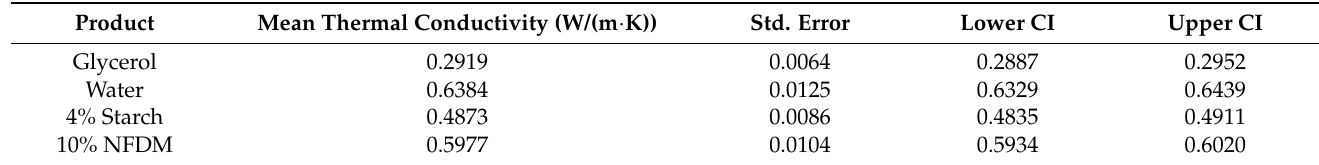
Table 2. Mean estimated thermal conductivities for all products and their corresponding 95% confidence interval (CI).